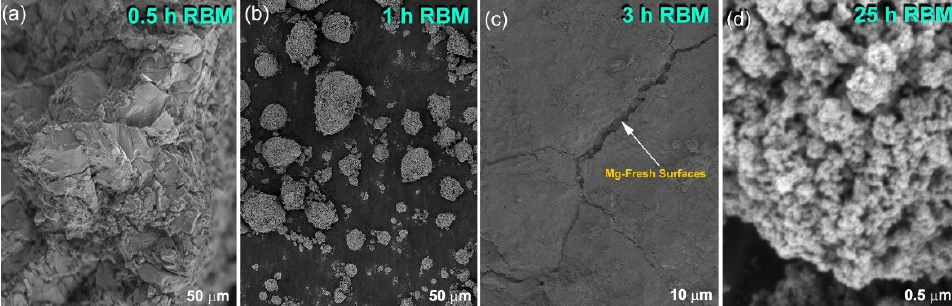
Figure 2. Field-emission scanning electron microscope (FE-SEM) micrographs of Mg powders obtained after RBM under pressurized hydrogen for ( a ) 0.5, ( b ) 1, ( c ) 3 and ( d ) 25 h.